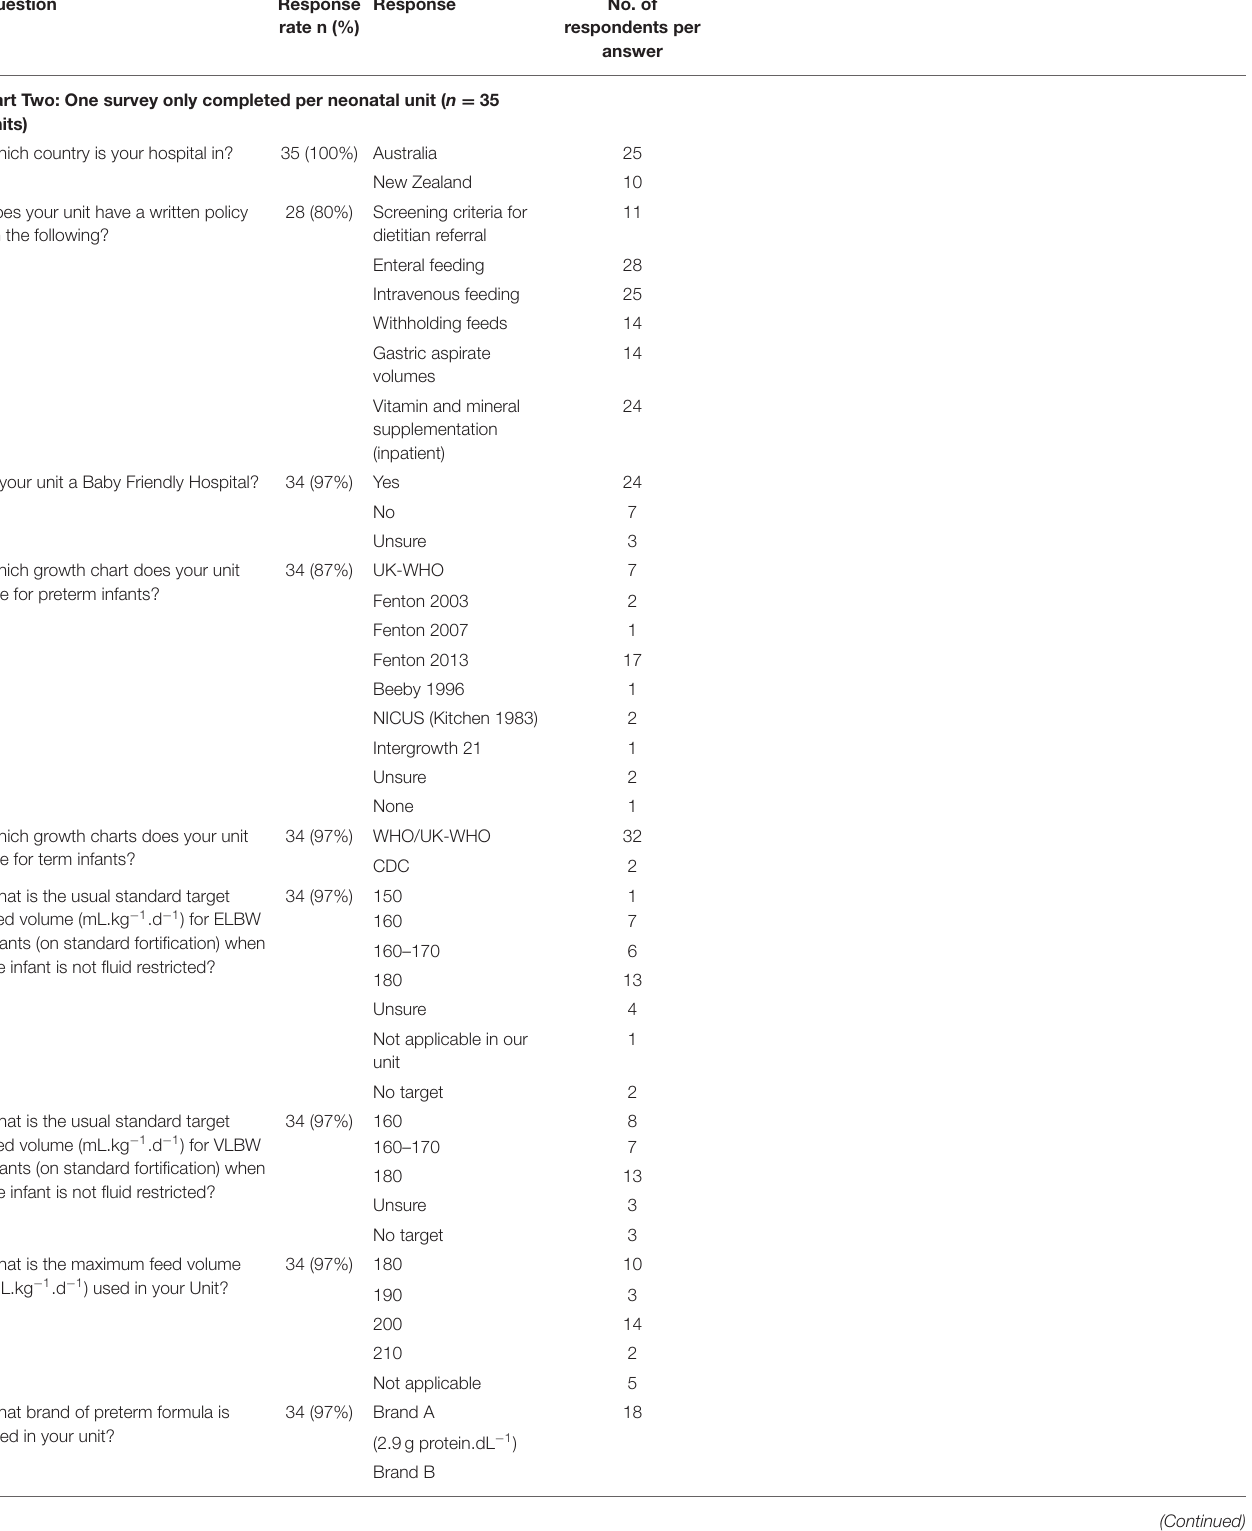
TABLE 2 | Survey-part two questions and responses. Question Response